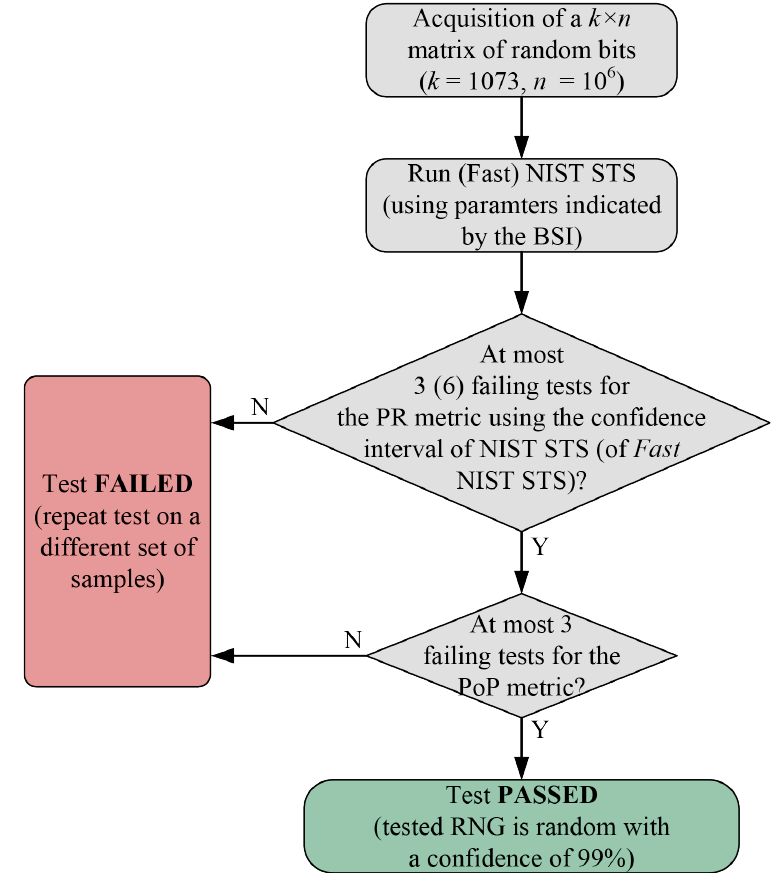
Figure 6. Flow diagram for randomness assessment when using the Fast NIST STS suite for a significance level of α =